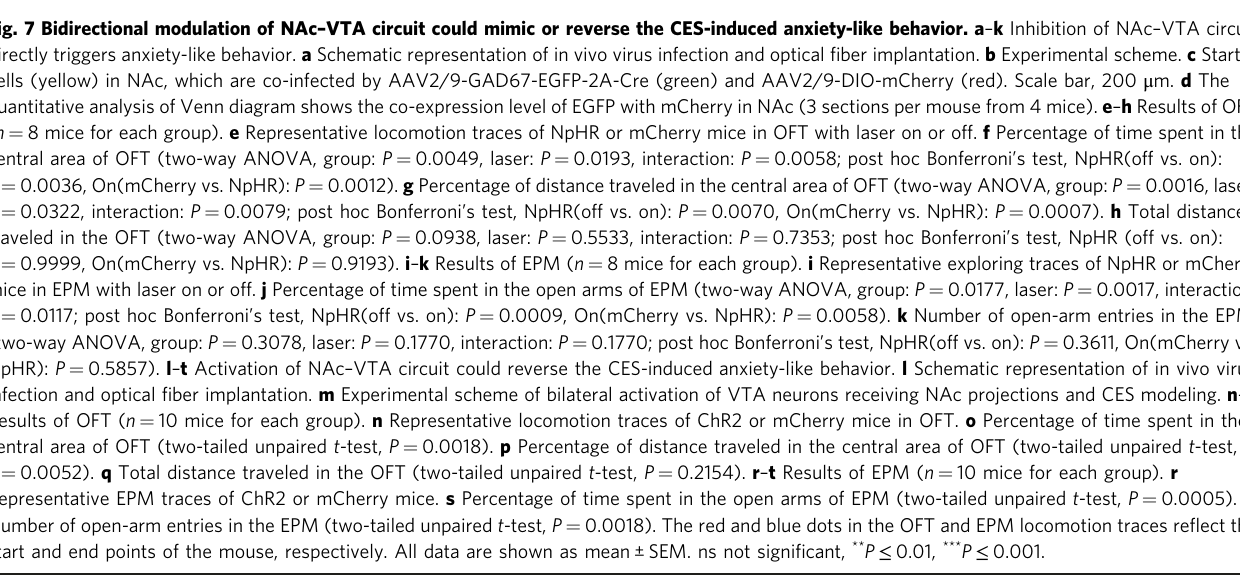
algorithms with a set of selected image features to produce pixel-based segmentations 68 . Second, a useful feature of ImageJ is the ROI Manager that allows selection of speci fi c areas (such as red only, green only, and double-labeled) for evaluation. Finally, the cells with red only, green only, and double-labeled were automatically counted by “ Analyze Particles ” tool (lower threshold level: 50, upper threshold level: 255). In addition, to compare multiple specimens, staining, image acquisition (exposure time and gain), and image analysis were performed in parallel for the entire set. Detailed quanti fi cation methods and procedures of histology data were shown in Supplementary Fig. 12.